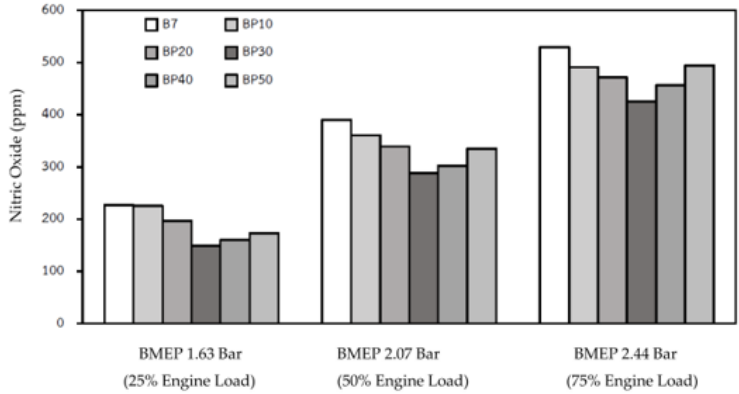
Figure 8. Effects of fuel blends on nitric oxide (NO)